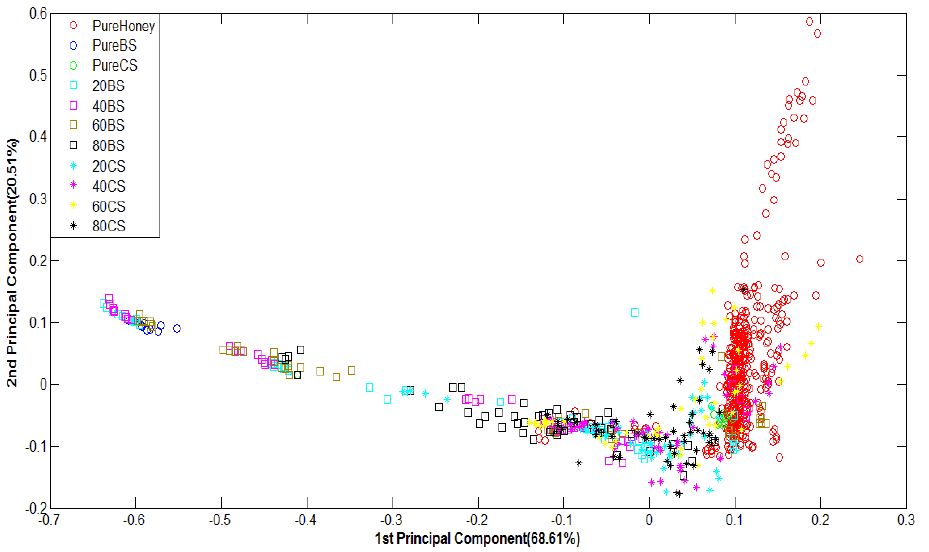
Figure 6. PCA plot of normalized E-nose